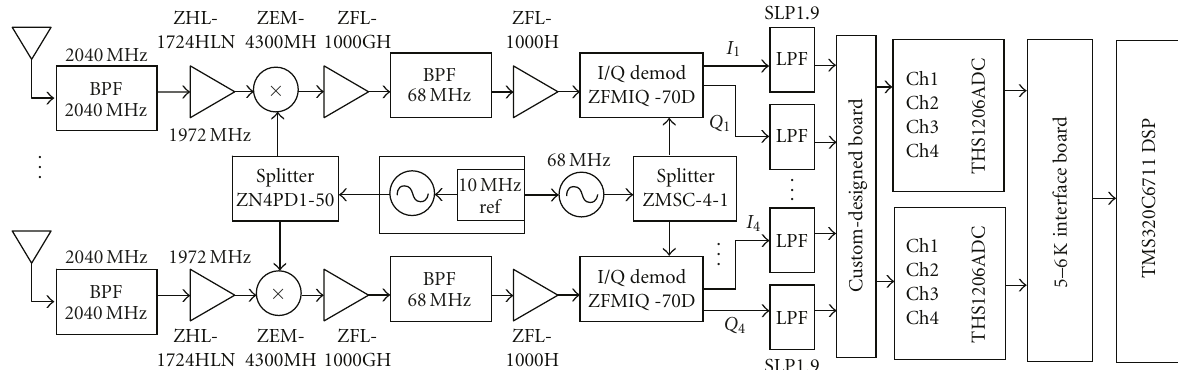
Figure 5: Simplified system block diagram of DBS system for the UKM testbed.